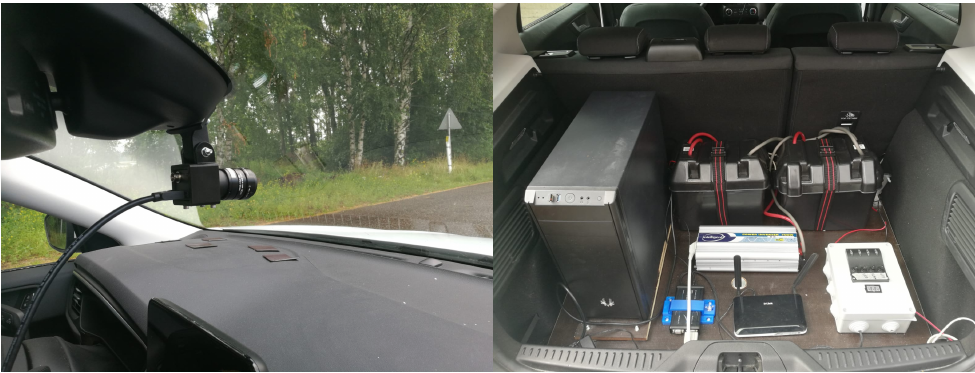
Figure 2. Hardware installations on the test vehicle. The windshield camera installation on the ( left ) and computational power with accessories on the ( right